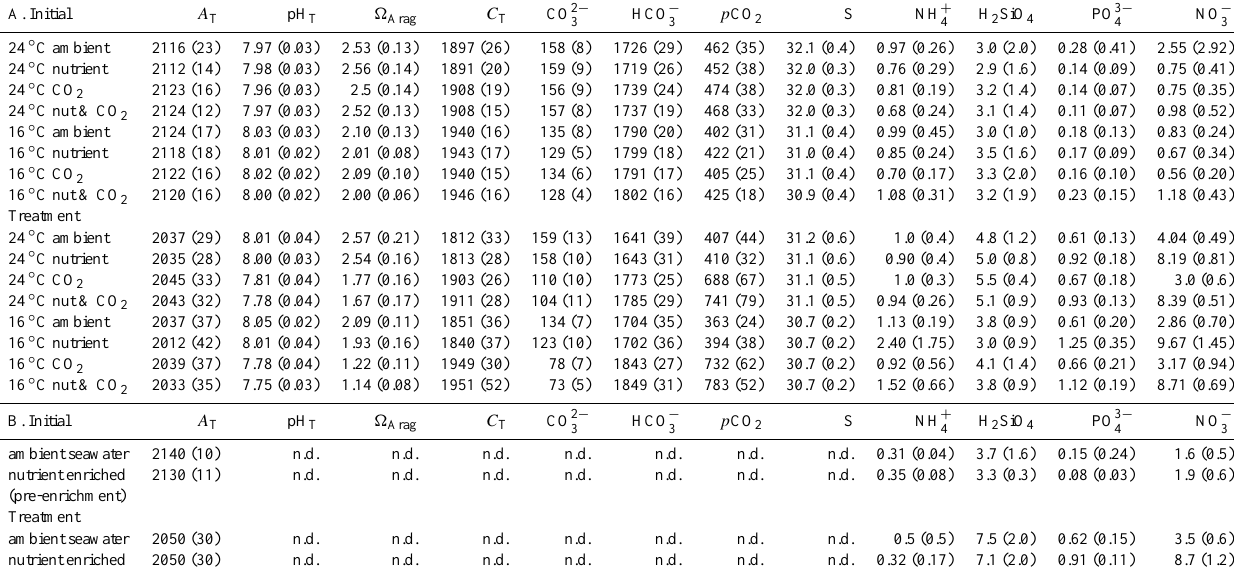
Table 1. Day-time water chemistry during initial and treatment phases for each aquarium (A), and source water chemistry (samples taken from the reservoirs supplying the aquaria) (B) Average A T (µmolkg − 1 ) , pH T (value at experimental temperature), aragonite saturation state ( (cid:127) Arag ) , CO 2 − (µmolkg − 1 ) , HCO − (µmolkg − 1 ) , p CO 2 (ppmv, water saturated air), salinity, NH + 3 3 Measured A T , temperature, salinity, nutrient, and pH T values were used to calculate aragonite saturation state and carbon speciation using a Matlab implementation of CO2SYS (van Heuven et al., 2009; using constants from Mehrbach et al., 1973; Dickson and Millero 1987; Dickson 1990) which incorporated the contribution of ammonia (Clegg and Whitfield, 1995). Nutrient values were not measured for all aquaria for all sampling points, average values for the respective period/aquarium were inserted for missing values for carbonate chemistry calculations. Values are means, standard deviation in parenthesis, n.d. = not